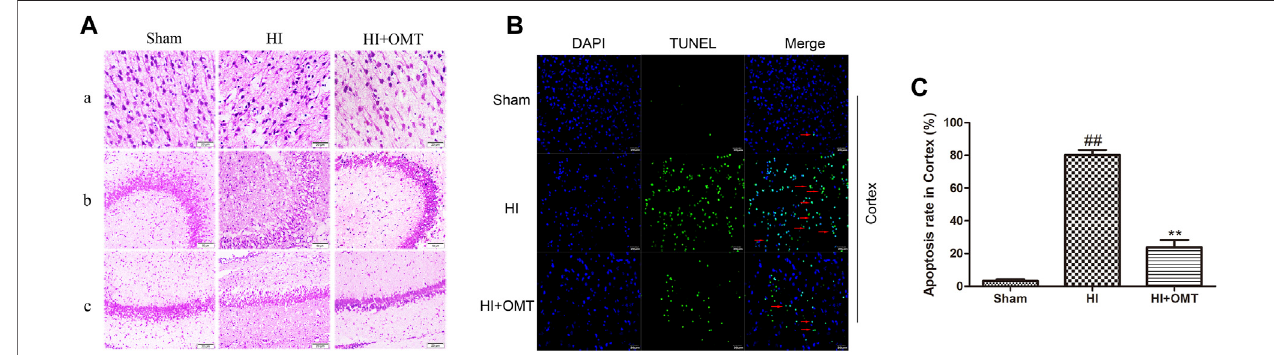
FIGURE 2 | Representative photographs of the hematoxylin and eosin (HE) and terminal deoxynucleotidyl transferase-mediated dUTP Nick End Labeling (TUNEL) staining in the hippocampus and cortex for the damaged neurons in the neonatal rats at 48 h after hypoxia-ischemia brain damage (HIBD). (A) Representative photographs of the morphological changes identi fi ed by HE staining: (A) cortex, (B) hippocampus CA3, and (C) hippocampus CA1. (B) Representative photographs of theneuronalapoptosisidenti fi edbyTUNELstaining. (C) Quantitativerepresentationoftheexpressionofapoptoticneuronsinthecortex.Theresultsareexpressed as mean ± SEM ( n (cid:1) 6 per group). ## p < 0.01 vs. the sham group; and ** p < 0.01 vs. the hypoxia-ischemia (HI) group.